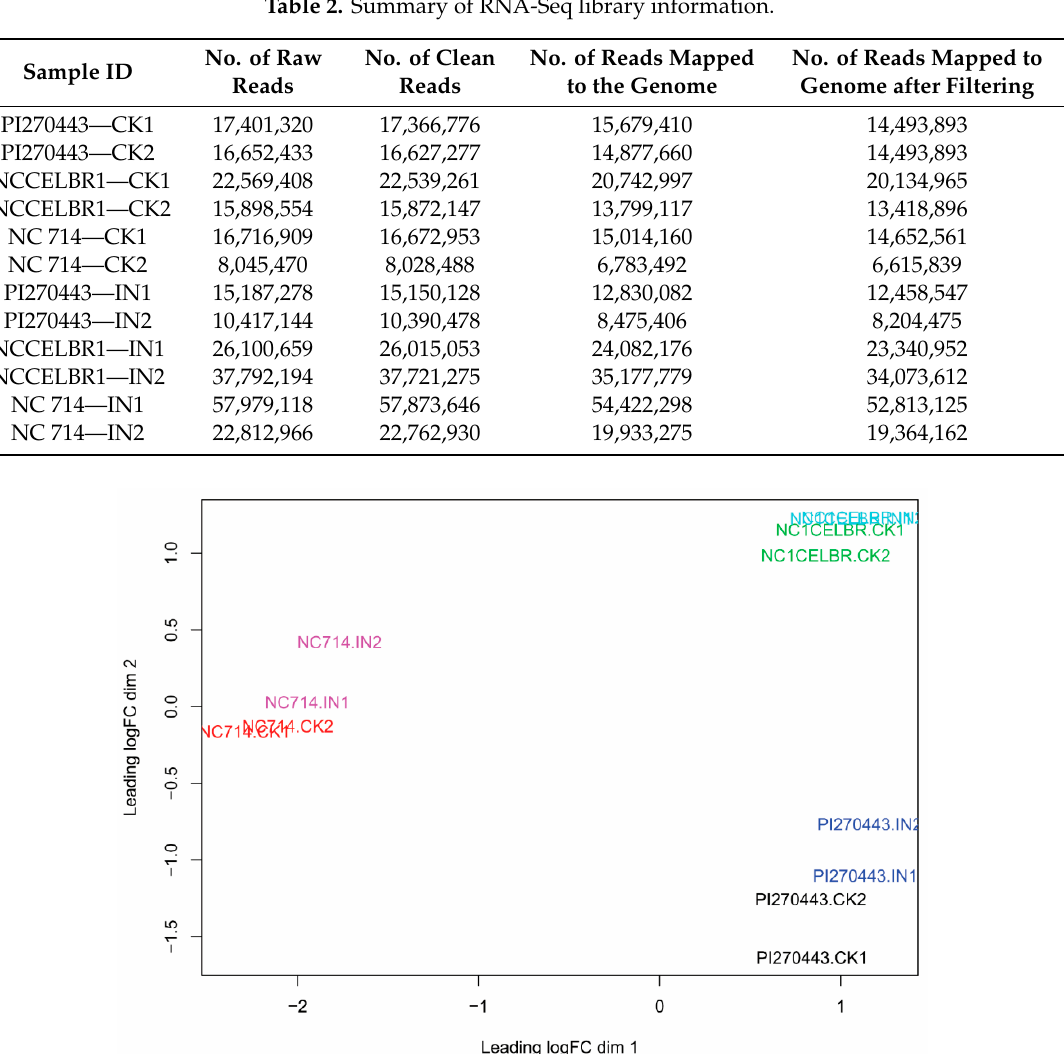
Table 2. Summary of RNA-Seq library information.